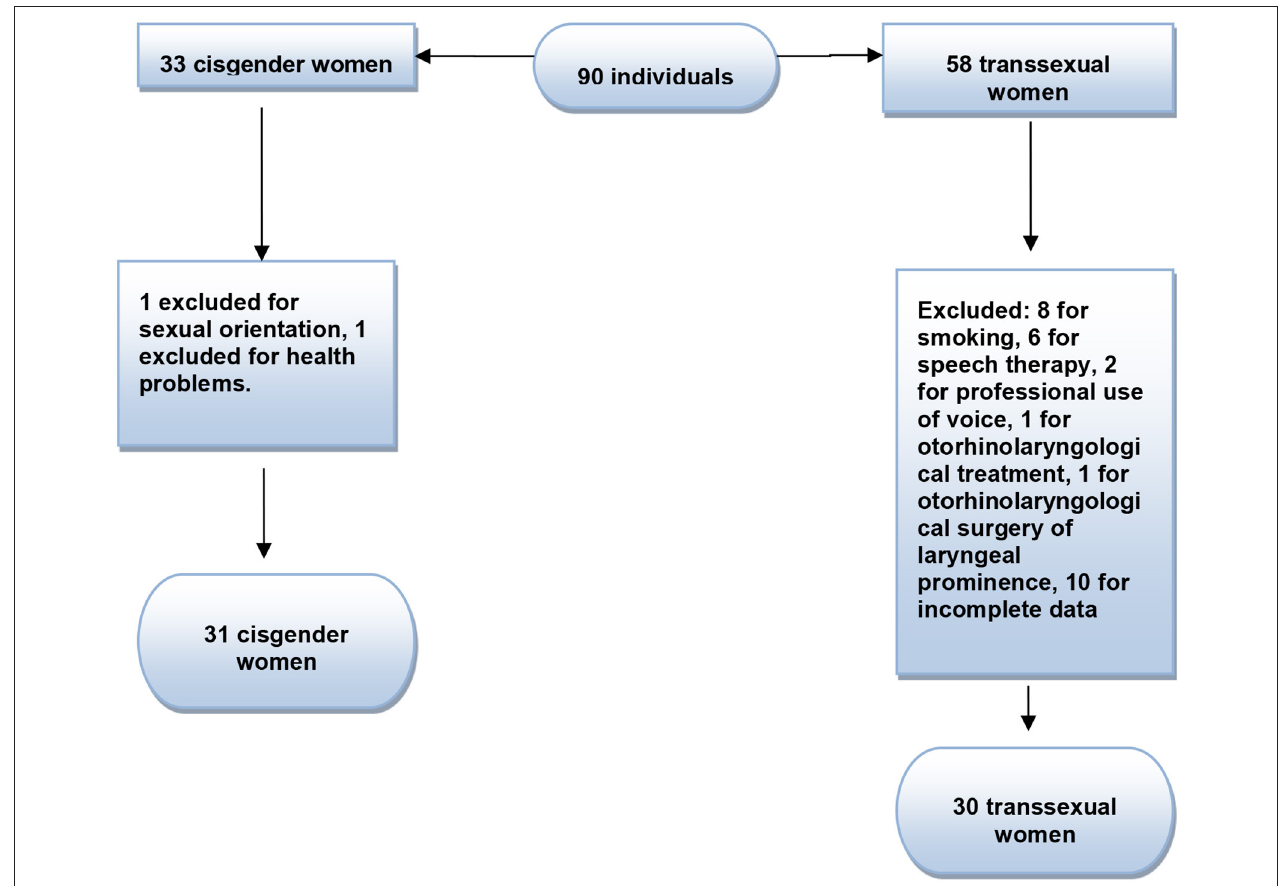
FIGURE 1 | Sample flow